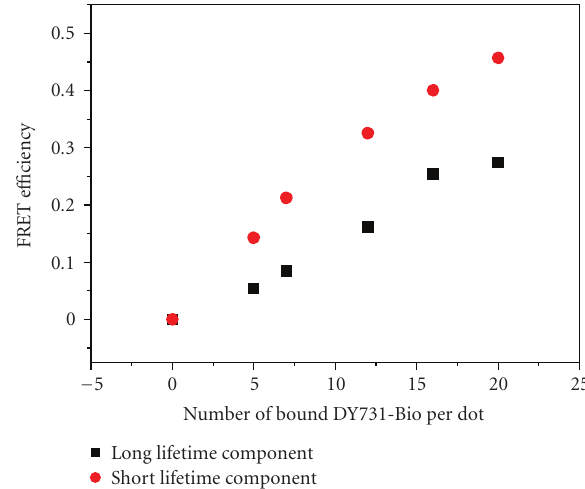
Figure 7: FRET e ffi ciency based on Qdot705-STV photolumi- nescence lifetime measurements plotted against DY731-Bio to Qdot705-STV labelling